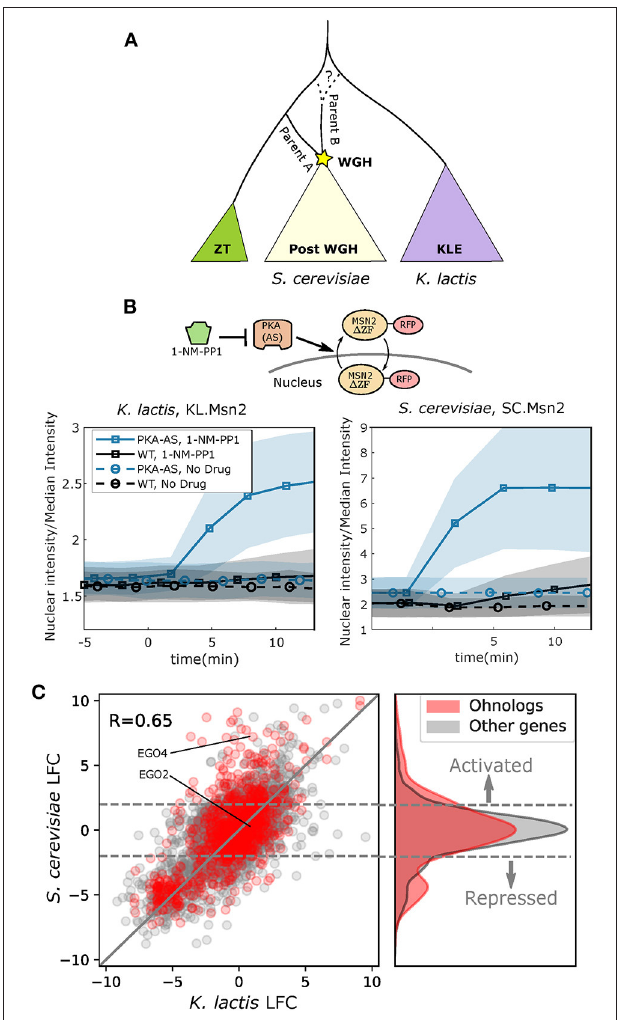
FIGURE 1 | Ohnologs are enriched in genes affected by PKA inhibition in S. cerevisiae. (A) Simplified schematic depicting the budding yeast Whole Genome Hybridization (WGH). The Kluyveromyces/Lachancea/Eremothecium (KLE) branch is shaded purple, and the Zygosaccharomyces/Torulaspora (ZT) branch is shaded green. Parent A is more closely related to the ZT branch than parent B. The dashed line illustrates the fact that the phylogenetic branch point of parent B has not been fully resolved and may be early on the ZT branch or on the KLE branch. (B) Msn2 nuclear localization in K. lactis (left) and S. cerevisiae (right) for WT and PKA Analog Sensitive (PKA-AS) strains following the addition of control media or 4uM 1-NM-PP1. Solid line represents the mean and the shaded area represents the standard deviation for at least 27 single cell measurements in K. lactis and at least 84 single cell measurements in S. cerevisiae . A diagram of the experimental system is shown. PKA-AS drives nuclear export of Msn2( 1 ZF)-RFP (denoted by SC.Msn2 in S. cerevisiae or KL.Msn2 in K. lactis ) and is inhibited by 1-NM-PP1. (C) Log Fold Change (LFC) comparing RNA sequencing data collected from strains in which PKA-AS was inhibited with 3uM 1-NMPP1 vs. DMSO controls. Data was collected after 50min in both S. cerevisiae ( y -axis) and K. lactis ( x -axis) following administration of the drug. LFC values are only shown for genes that had orthologs in both species. Genes that are ohnologs in S. cerevisiae are colored red, and all other genes are colored gray. The y = x line is shown in gray. The differentially expressed ohnologs EGO2 and EGO4, which share a common ortholog in K. lactis , are highlighted. Horizontal dashed gray lines (Continued)